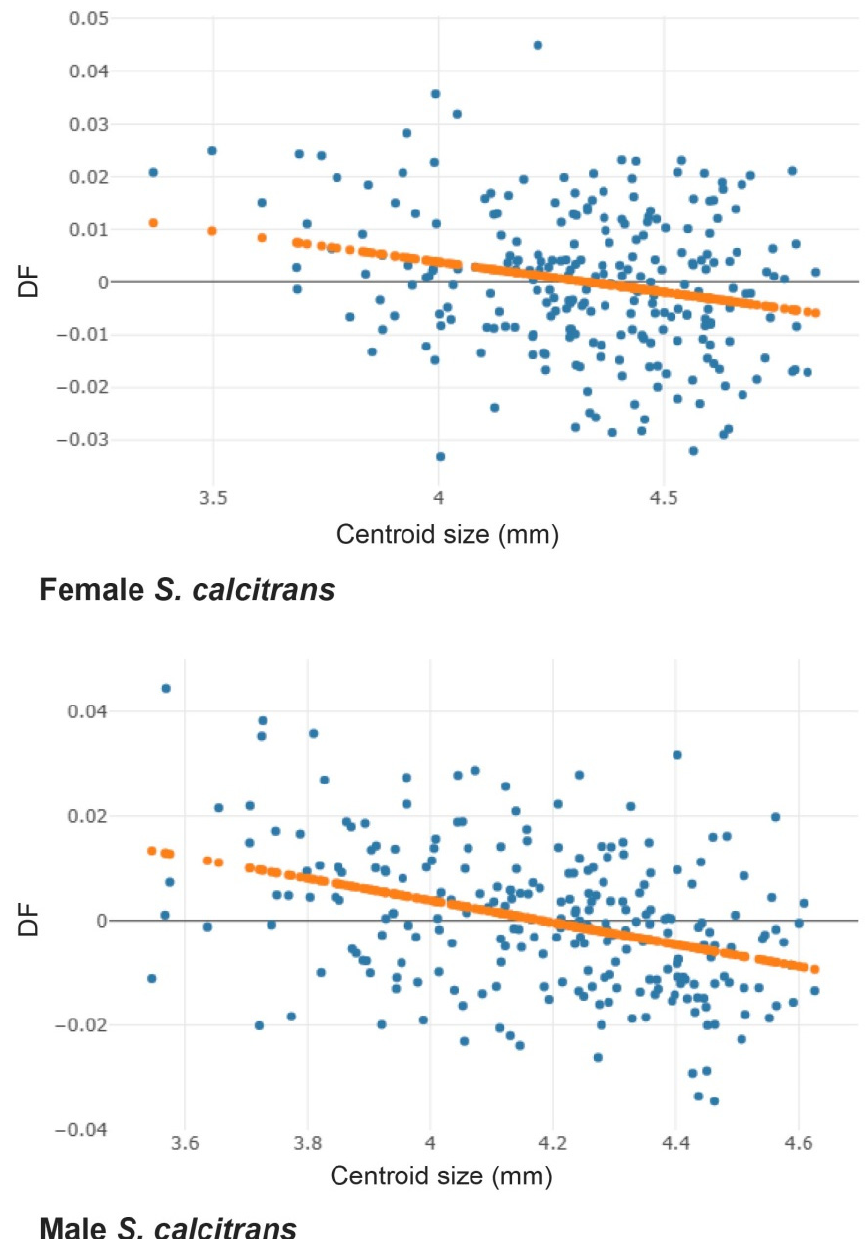
Figure 3. Linear regression between wing size (CS) and shape (DF) of female ( top ) and male ( bottom ) S. calcitrans . Orange dotted lines indicate linear regression prediction.